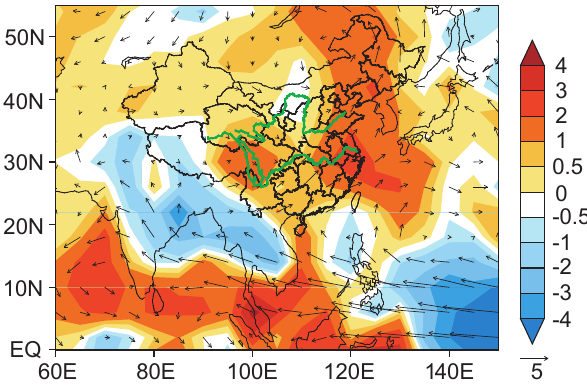
Fig. 7. The differences in summer (JJAS) mean precipitation (mm/day) and 850hPa winds (m/s) of GEOS4 between 1998 and 2002 (the former minus latter). Meteorological fields are from the GEOS-4 assimilated